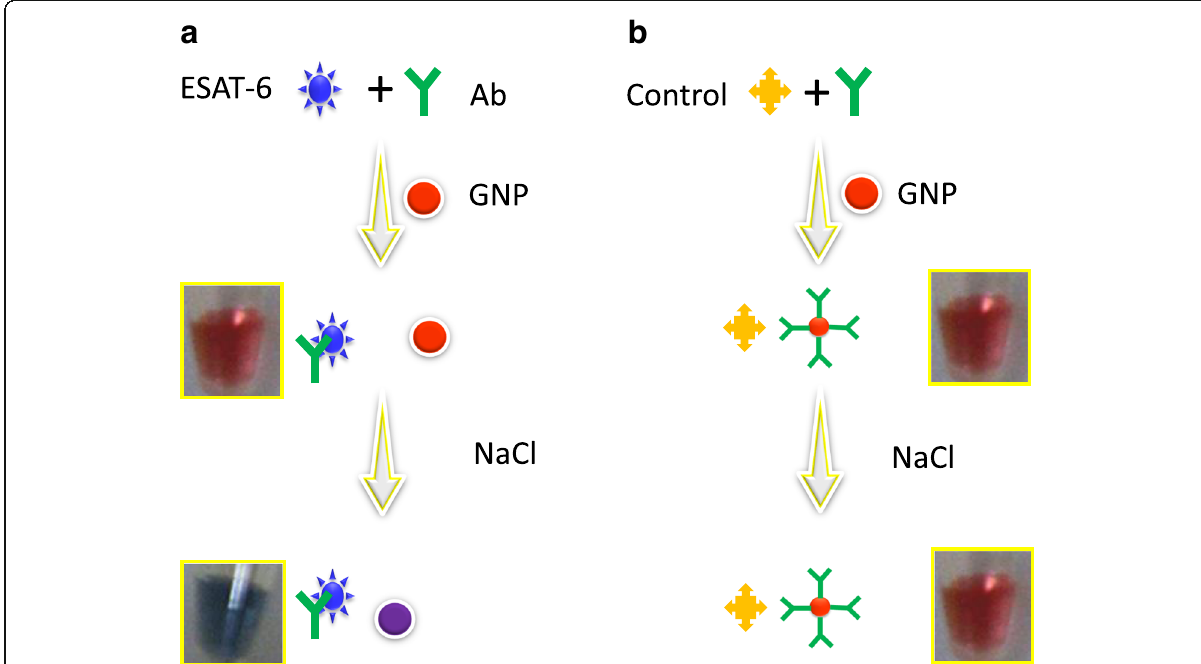
Fig. 1 Schematic representation for ESAT-6 detection by a single-step pre-complexed antibody-based colorimetric assay. a Strategy for anti-ESAT- 6 antibody pre-complexed ESAT-6. b Strategy for anti-ESAT-6 antibody pre-complexed CFP-10 (control